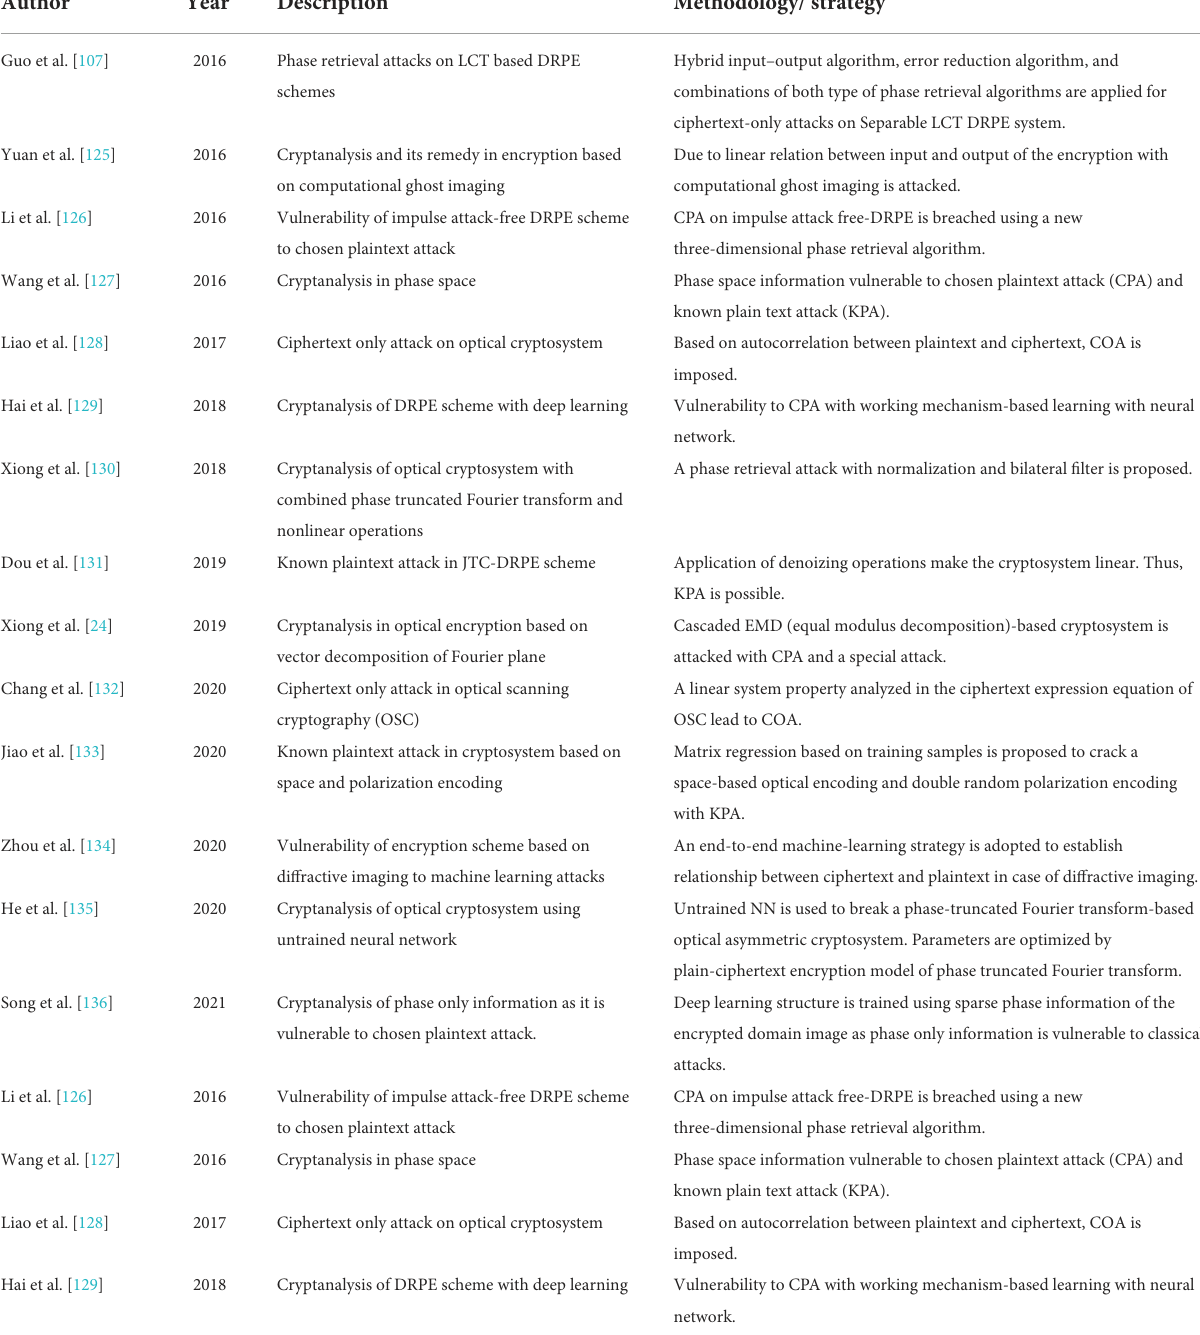
TABLE 4 Cryptanalytic approaches in optical/DRPE-based encryption schemes